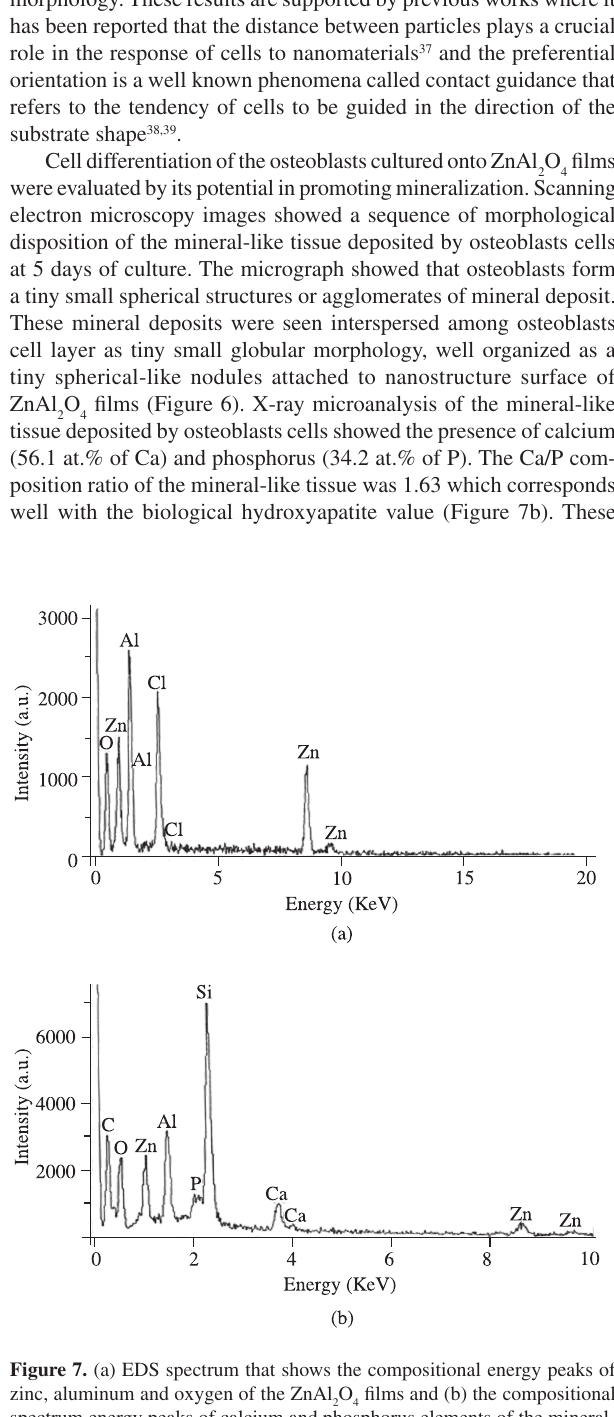
Figure 6. Scanning electron micrographs at different magnifications of the mineral-like tissue deposited by the osteoblasts cells cultured onto ZnAl films after 5 days of culture. It is revealed a higher amount of nanospherical globular-like structures of the mineral-like tissue.